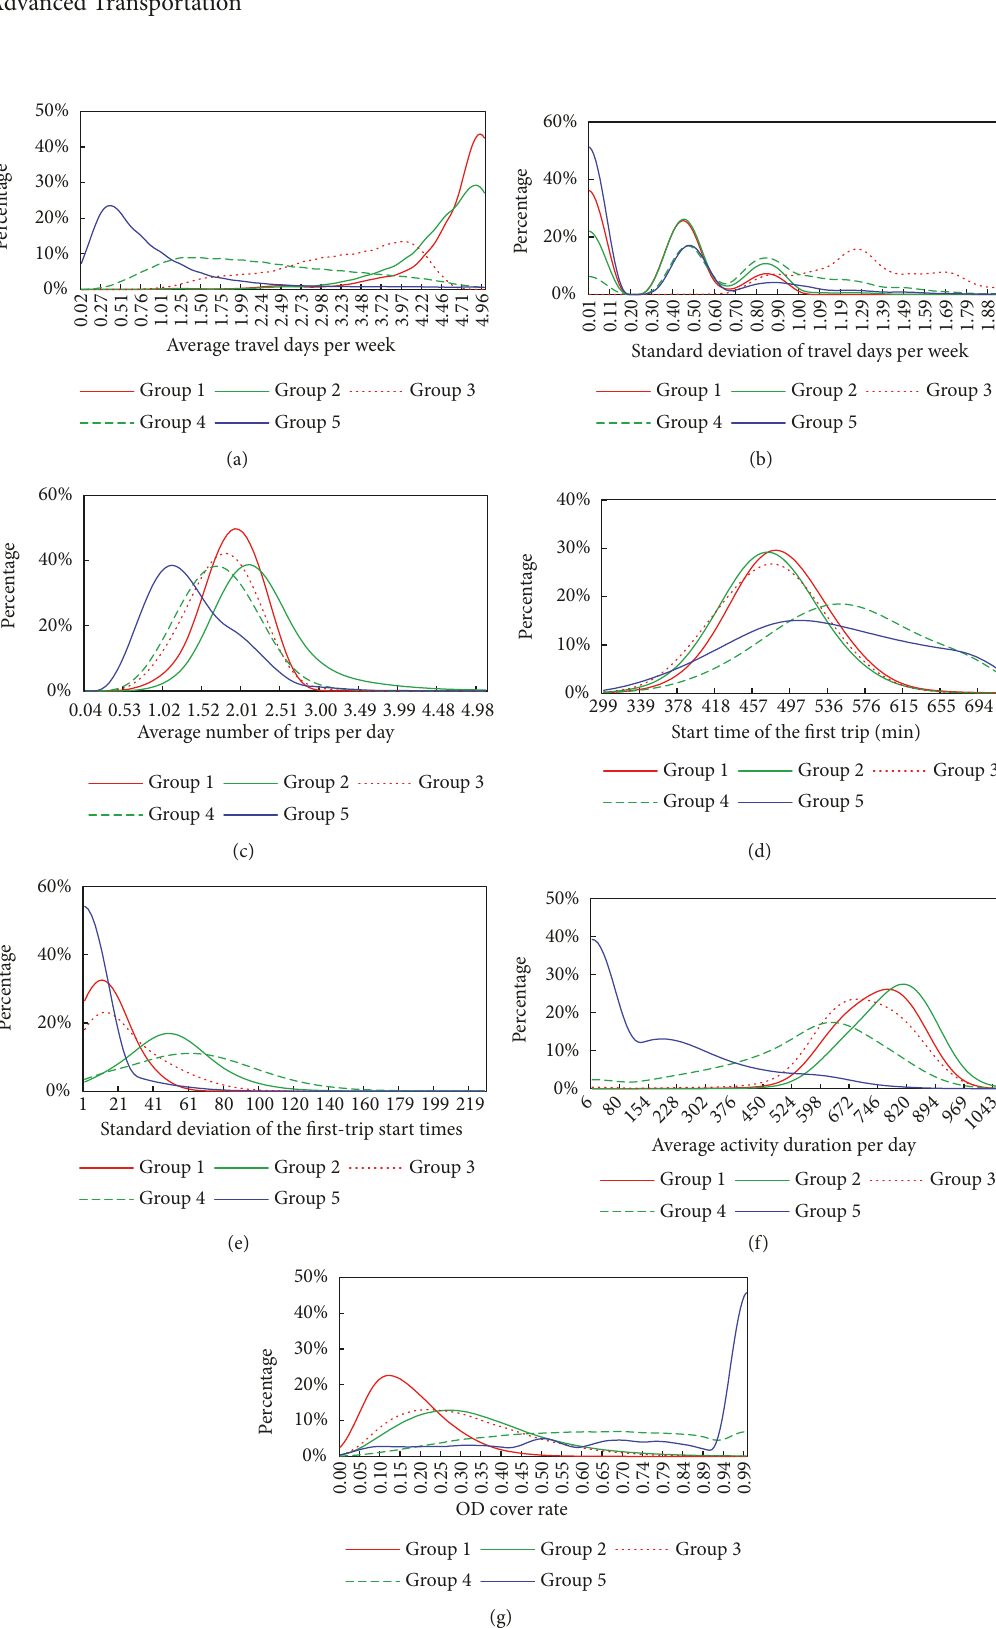
Figure 3: Distributions of the classification indexes for different passenger